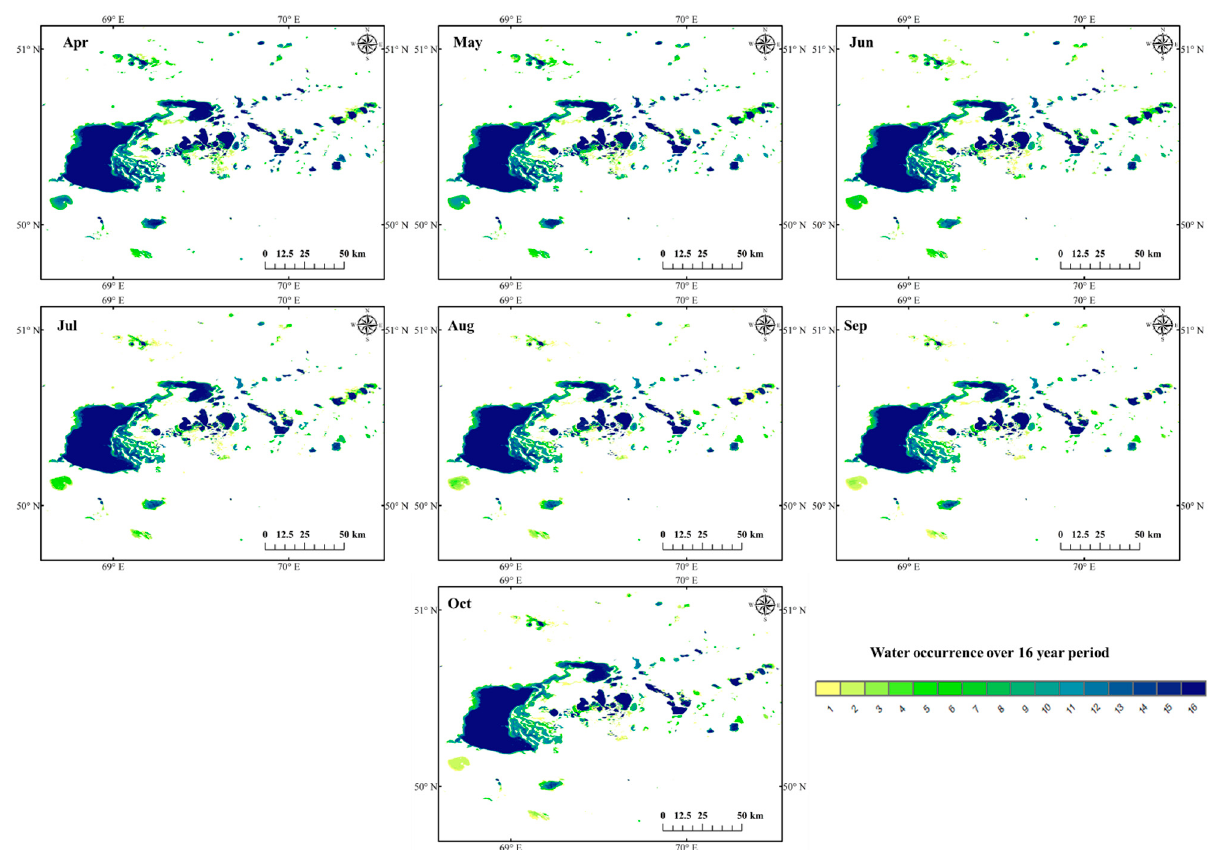
Figure 11. Monthly dynamics of water bodies for Tengiz Lake over the 16-year study period. Table 6. The monthly dynamics statistics of the Aral Sea and Tengiz